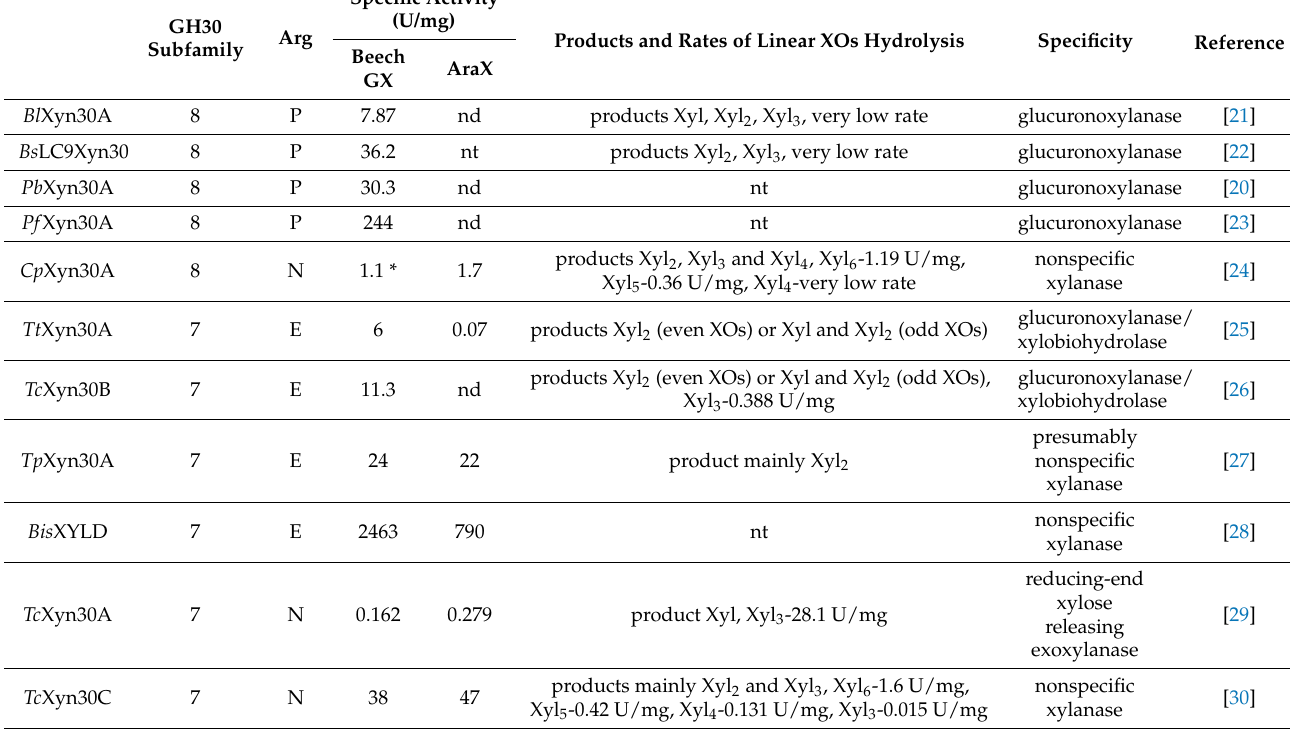
Table 2. Specific activities of characterized GH30 xylanases on beech GX, wheat AraX and action of the enzymes on linear XOs. Abbreviations: P, presence of prokaryotic Arg; E, presence of eukaryotic Arg and N, absence of both